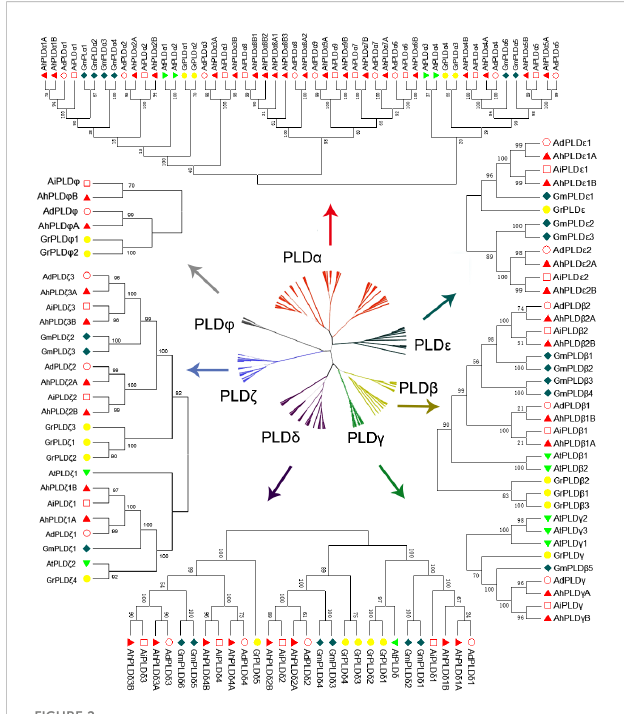
FIGURE 2 Phylogenetic tree of PLD gene family with bootstrap values among three Arachis species, Arabidopsis , soybean and cotton. The red, yellow, green, purple, dark green, blue and gray branches represent a , b , g , d , e , z and f isoforms, respectively. The red circles, red squares, red triangles, green triangles, dark green diamonds and yellow circles represent the proteins of A. duranensis (Ad), A. ipaensis (Ai), A. hypogaea (Ah), Arabidopsis (At), soybean (Gm) and cotton (Gr),